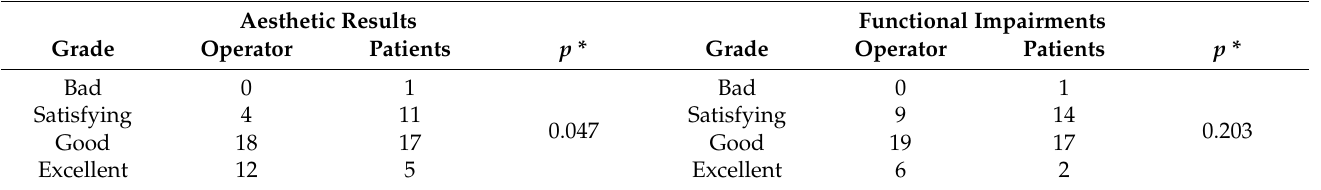
Table 6. Operator and patient subjective assessment of the aesthetic results and functional